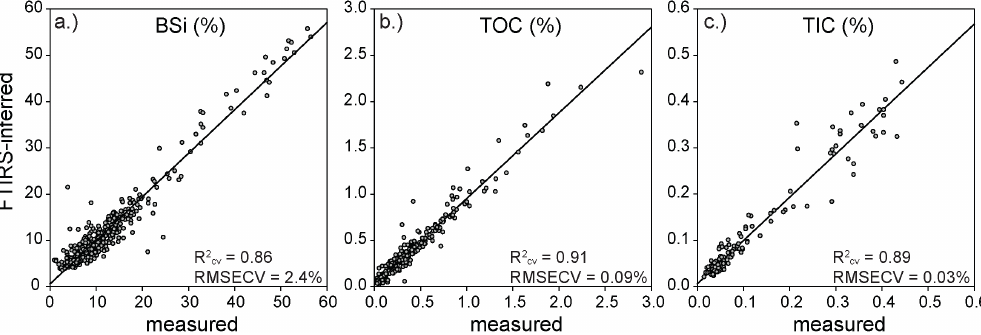
Fig. 2. Conventionally measured ( x axis) versus FTIRS-inferred concentrations ( y axis) of (a) biogenic silica (BSi), (b) total organic carbon (TOC), and (c) total inorganic carbon (TIC) with the cross-validated coefficient of determination ( R 2 cross-validation (RMSECV) resulting from the internal validation of the developed calibration models. The calibration models are based on sediment samples from percussion piston cores PG1351 ( n =83 for BSi, n =156 for TOC) and Lz1024 ( n =204 for BSi) and samples distributed throughout the entire drill core composite profile of ICDP site 5011-1 ( n =133 for BSi, n =153 for TOC, n =152 for TIC).